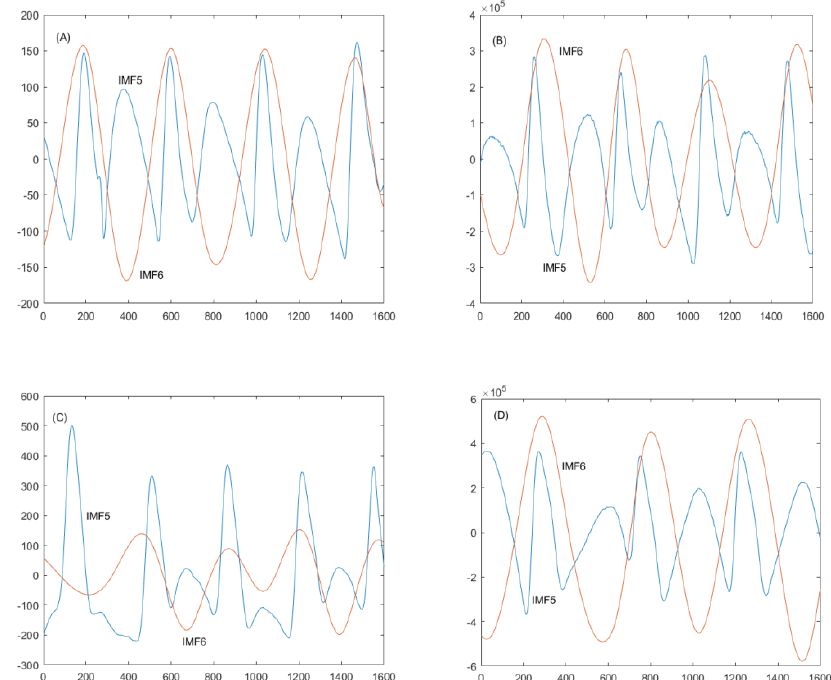
Table 3. (A). One-way analysis of variance for the three indices (PWV finger , SI new -RP, and SI new -DVP) applied to Group 1 (healthy middle-aged subjects) and Group 2 (type 2 diabetic subjects).